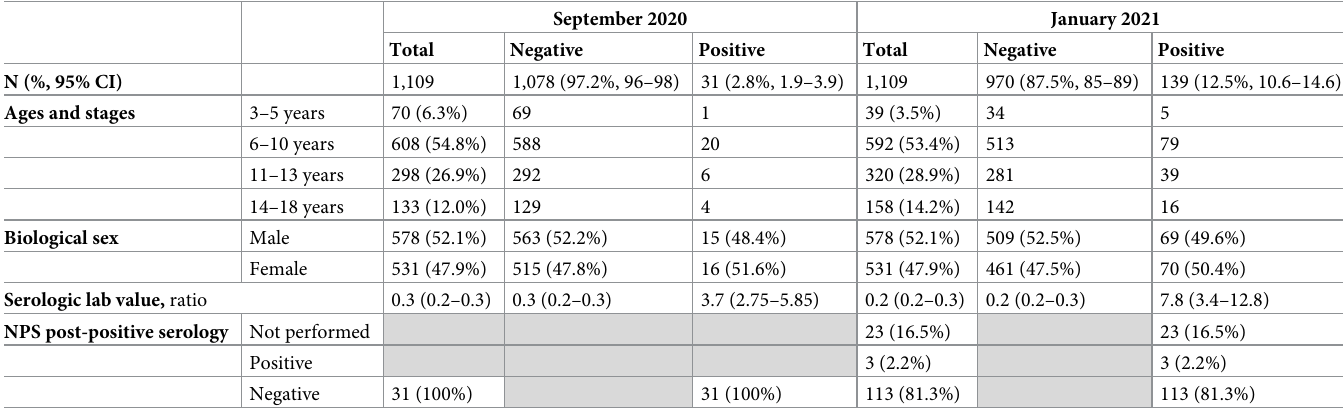
Table 1. Characteristics of study subjects by two time period and serologic